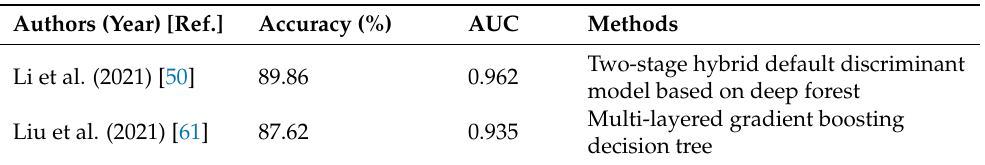
Table 10. Accuracy and area under the receiver operating characteristic curve (AUC) values of deep-learning-based classifiers for the Japanese dataset.